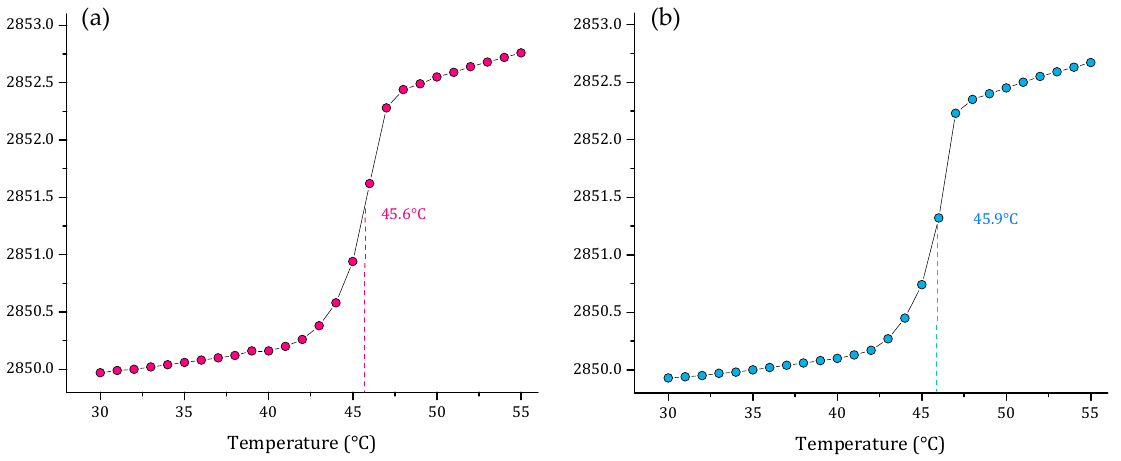
Figure 4. Peak positions of the ν s CH 2 vibration bands of the methylene groups as a function of tem- perature of ( a ) P. aeruginosa PE:PG:CL 65:23:12 ( w / w ) and ( b ) E. coli PE:PG:CL 75:20:5 ( w / w ) multi- component lipid systems in 10 mM HEPES, 500 mM NaCl, 1 mM EDTA, pH 7.4.